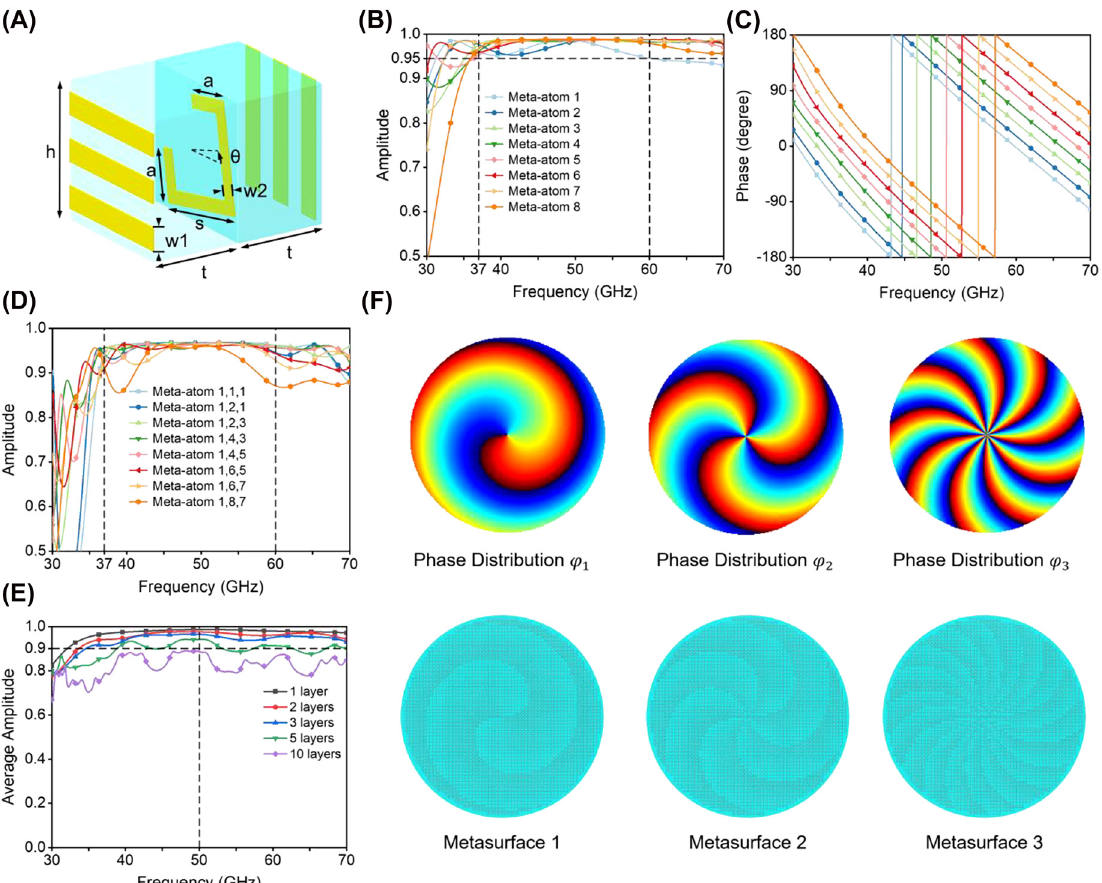
Figure 2: Characterization of the basic highly transmissive building block and design of metasurfaces. (A)Schematicstructureofthedesignedbroadbandhigh-transmissionmeta-atom.Thegeometricparametersofthemeta-atomare h =1.5mm, w 1 =0.25 mm, w 2 =0.15 mm, and t = 0.5 mm. (B)And (C) are, respectively, thesimulated transmission amplitudeandphase shift of the fi rst 8 designedmeta-atomssubjecttoanx-polarizedincidentwave.(D)Simulated transmissionamplitudeof differentcombinations ofthreelayers of cascaded meta-atoms. (E) Simulated transmission amplitude of 1, 2, 3, 5 and 10 layers of cascaded meta-atoms. Each spectrum is the BVGs (1st row) and middle gapped-ring layers (2nd row) of the three engineered